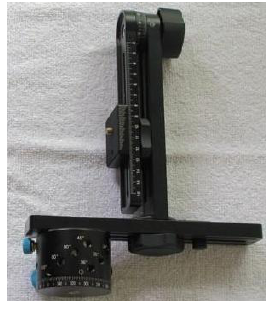
Figure 3. Nodal Ninja 5R + D16 Rotator